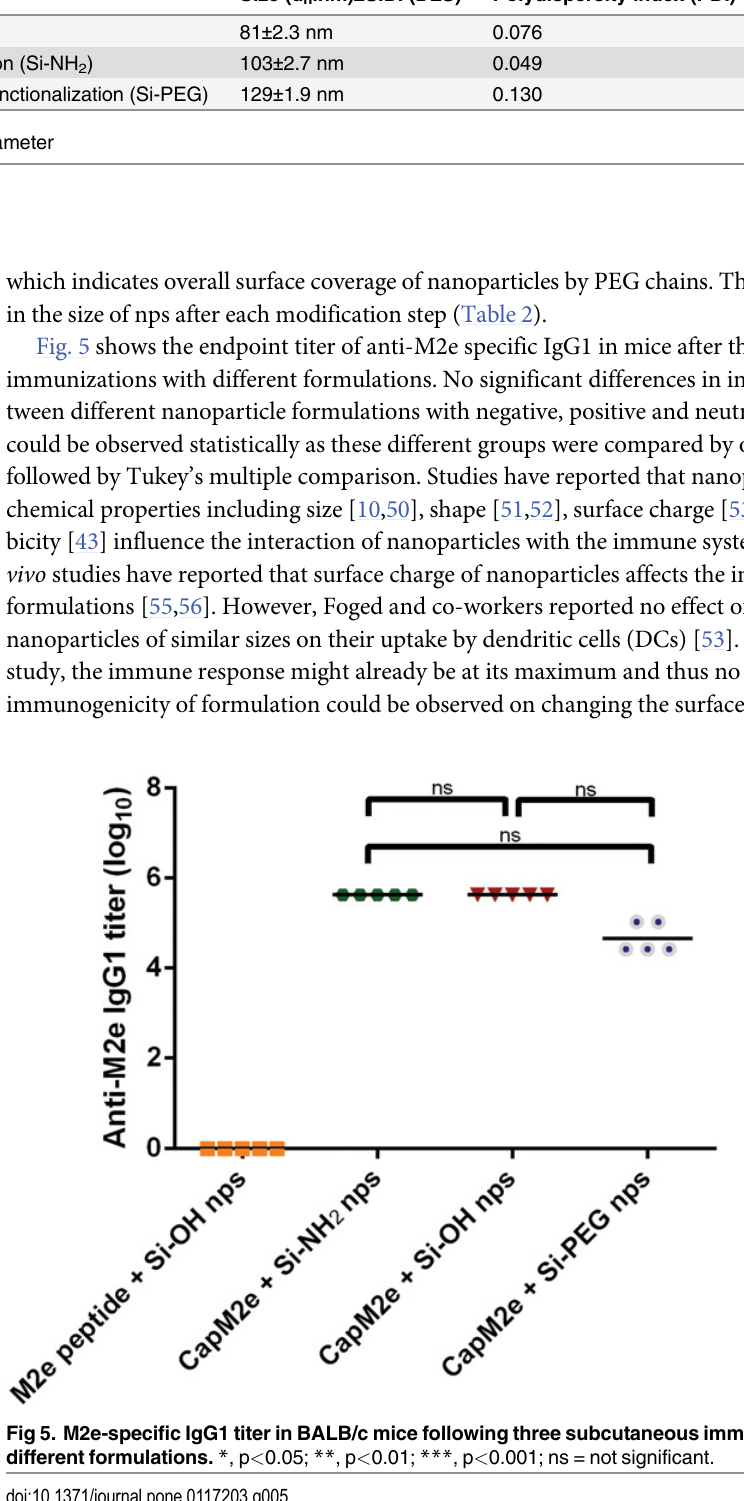
Table 2. Characteristics of silica nanoparticles with different surface properties. Nanoparticles